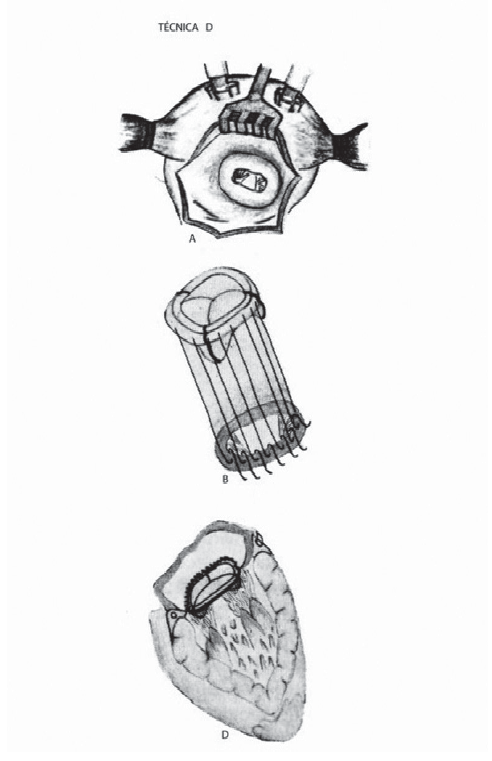
Fig. 4 - Prótese mitral com preservação dos elementos do sistema subvalvar: conservação de todo o aparelho valvar (Évora et al., Rev Bras Cir Cardiovasc. 1988;3(1):36-49)